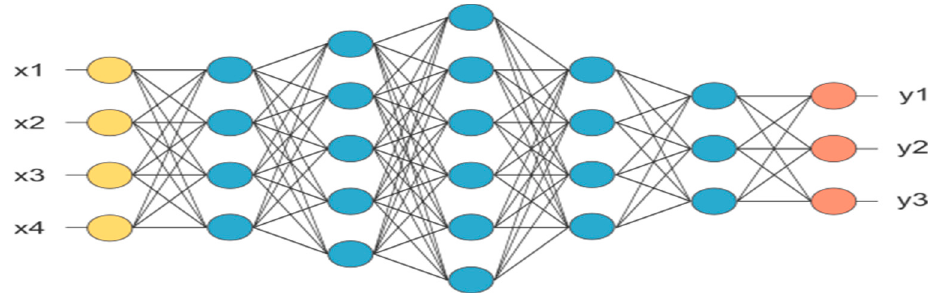
Figure 4. Architecture of a convolutional neural